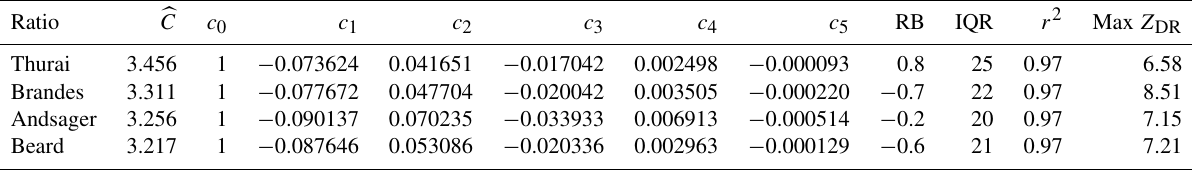
Table 3. Fitted values of b C (Eq. 16) and c i (Eq. 14), by drop axis ratio function (Ratio). M 3 estimation performance in the training data is shown in terms of median relative bias (RB, %), IQR of relative bias (IQR, %pts), and r 2 . Max Z DR (dB) shows the maximum value of Z DR each relationship can use.